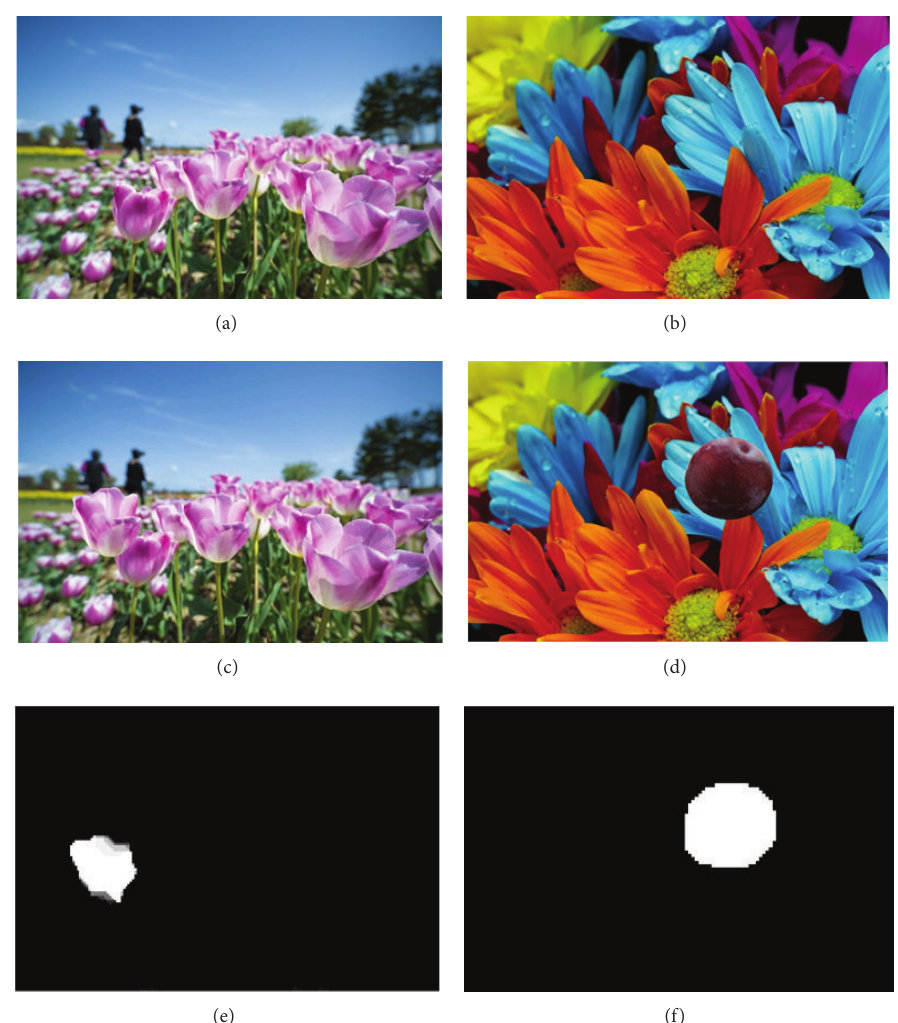
Figure 10: The detection result of copy-move and splicing forgeries: (a) and (b): intact pictures; (c) and (d): forged pictures; and (e) and (f): detection result.